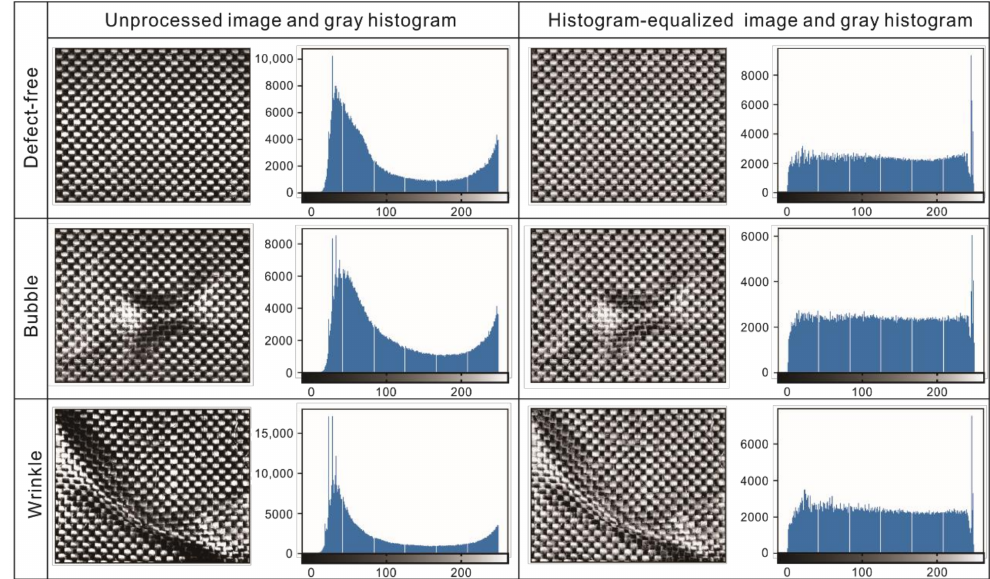
Figure 7. Three kinds of grayscale images (defect-free, bubble, and wrinkle) and their gray histograms with/without histogram